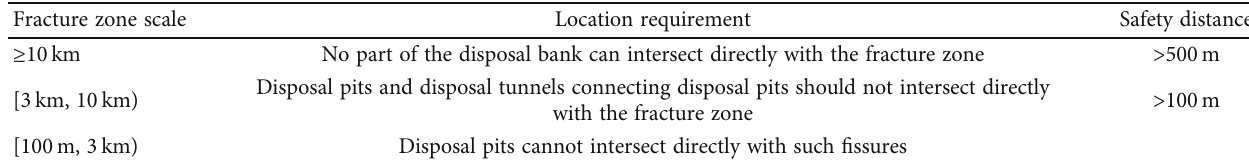
Figure 4: Exploratory trench and fault gouge. Table 3: Classi fi cation of fracture